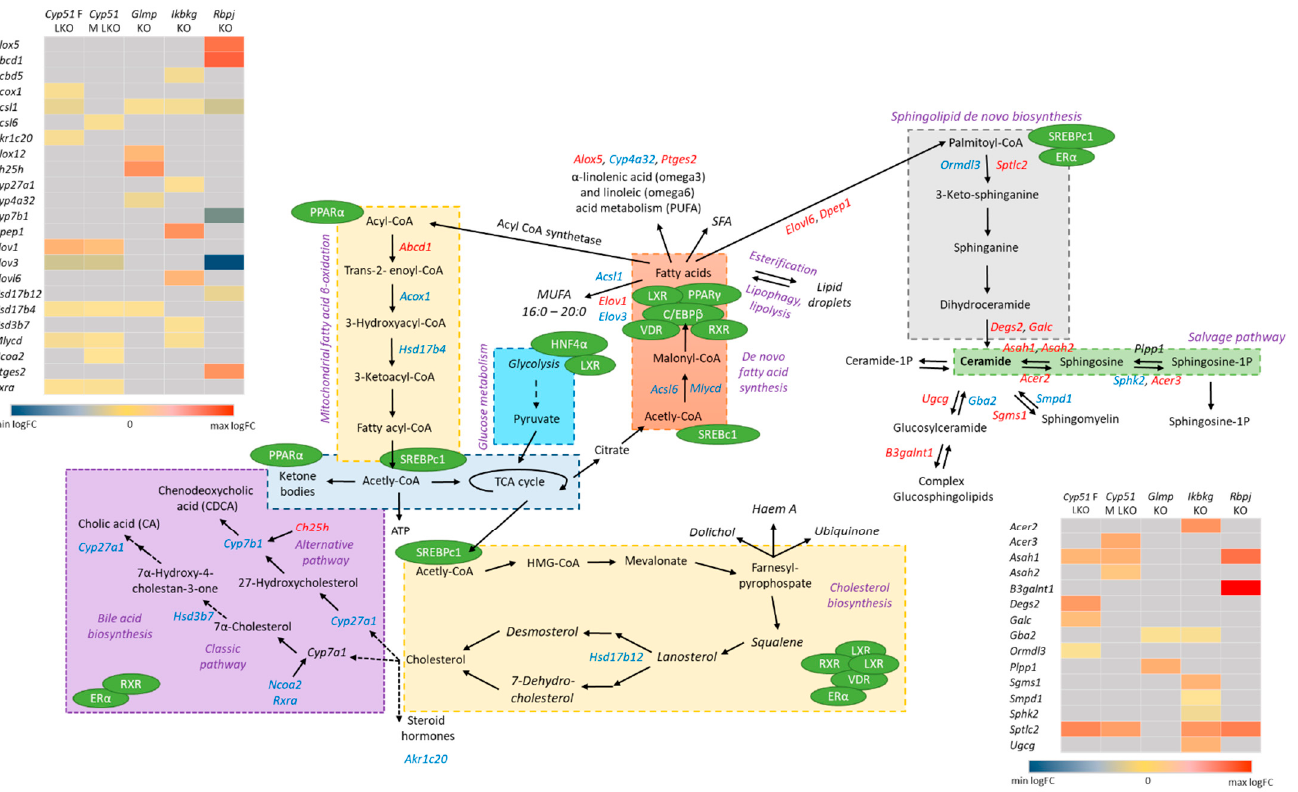
Figure 6. Unique lipid metabolite’s rearrangements in mouse liver fibrotic models. Pathways analyses and GEM subsystems detected model-specific deregulation of lipid metabolism in genetic models. Blue color indicates downregulated DEGs, while red are upregulated DEGs. Grey in heat maps represents insignificant expression. Green circles are detected TFs in liver mouse models, which regulate different metabolic pathways (violet). Legend of heat maps are shown at the bottom.